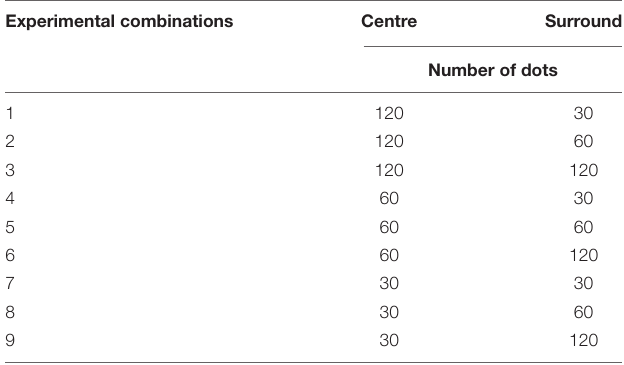
TABLE 1 | An example of the experimental conditions (number of dots) presented on one side of the display. Experimental combinations Centre Surround